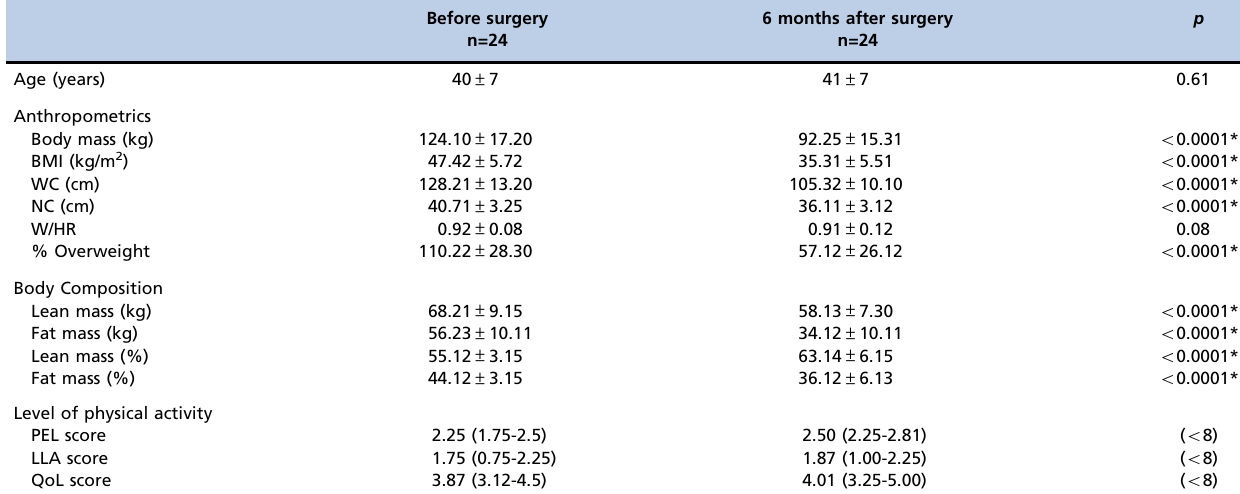
Table 1 - Anthropometric characteristics, body composition and level of physical activity of morbidly obese women before and after bariatric surgery. Before surgery 6 months after surgery